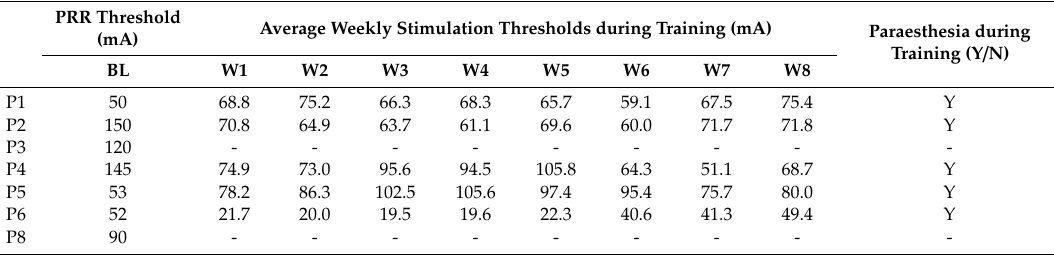
Table 2. Participant stimulation